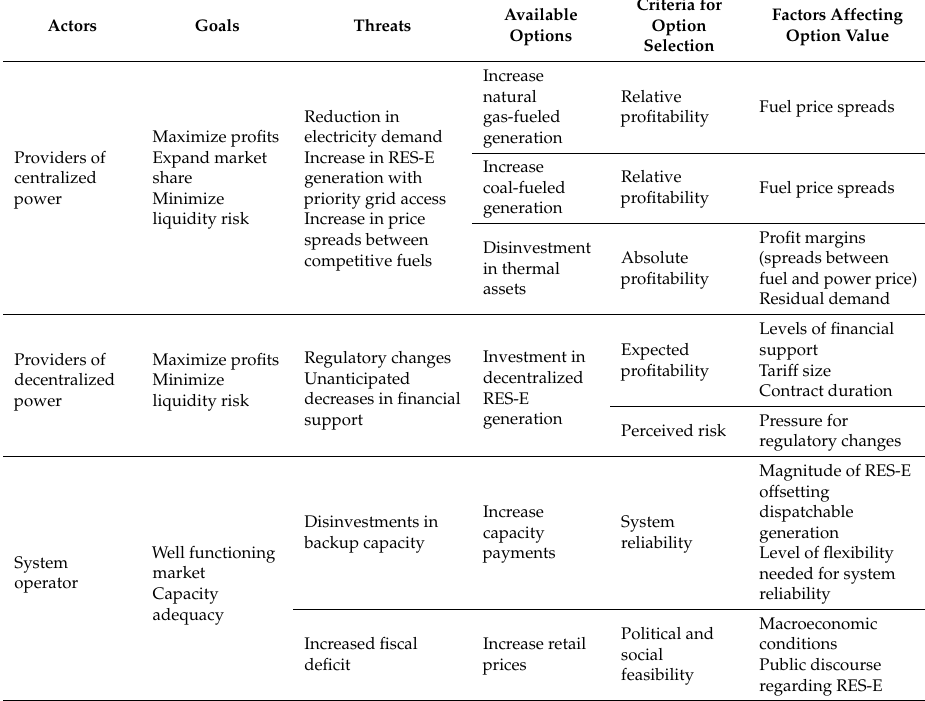
Table 2. The actors’ perceptions in a power market. We summarize the perspectives of the aforementioned actors for the case of the power market. We apply the conceptual framework outlined in Section 2 in the power market and demonstrate the workability of the approach proposed here.